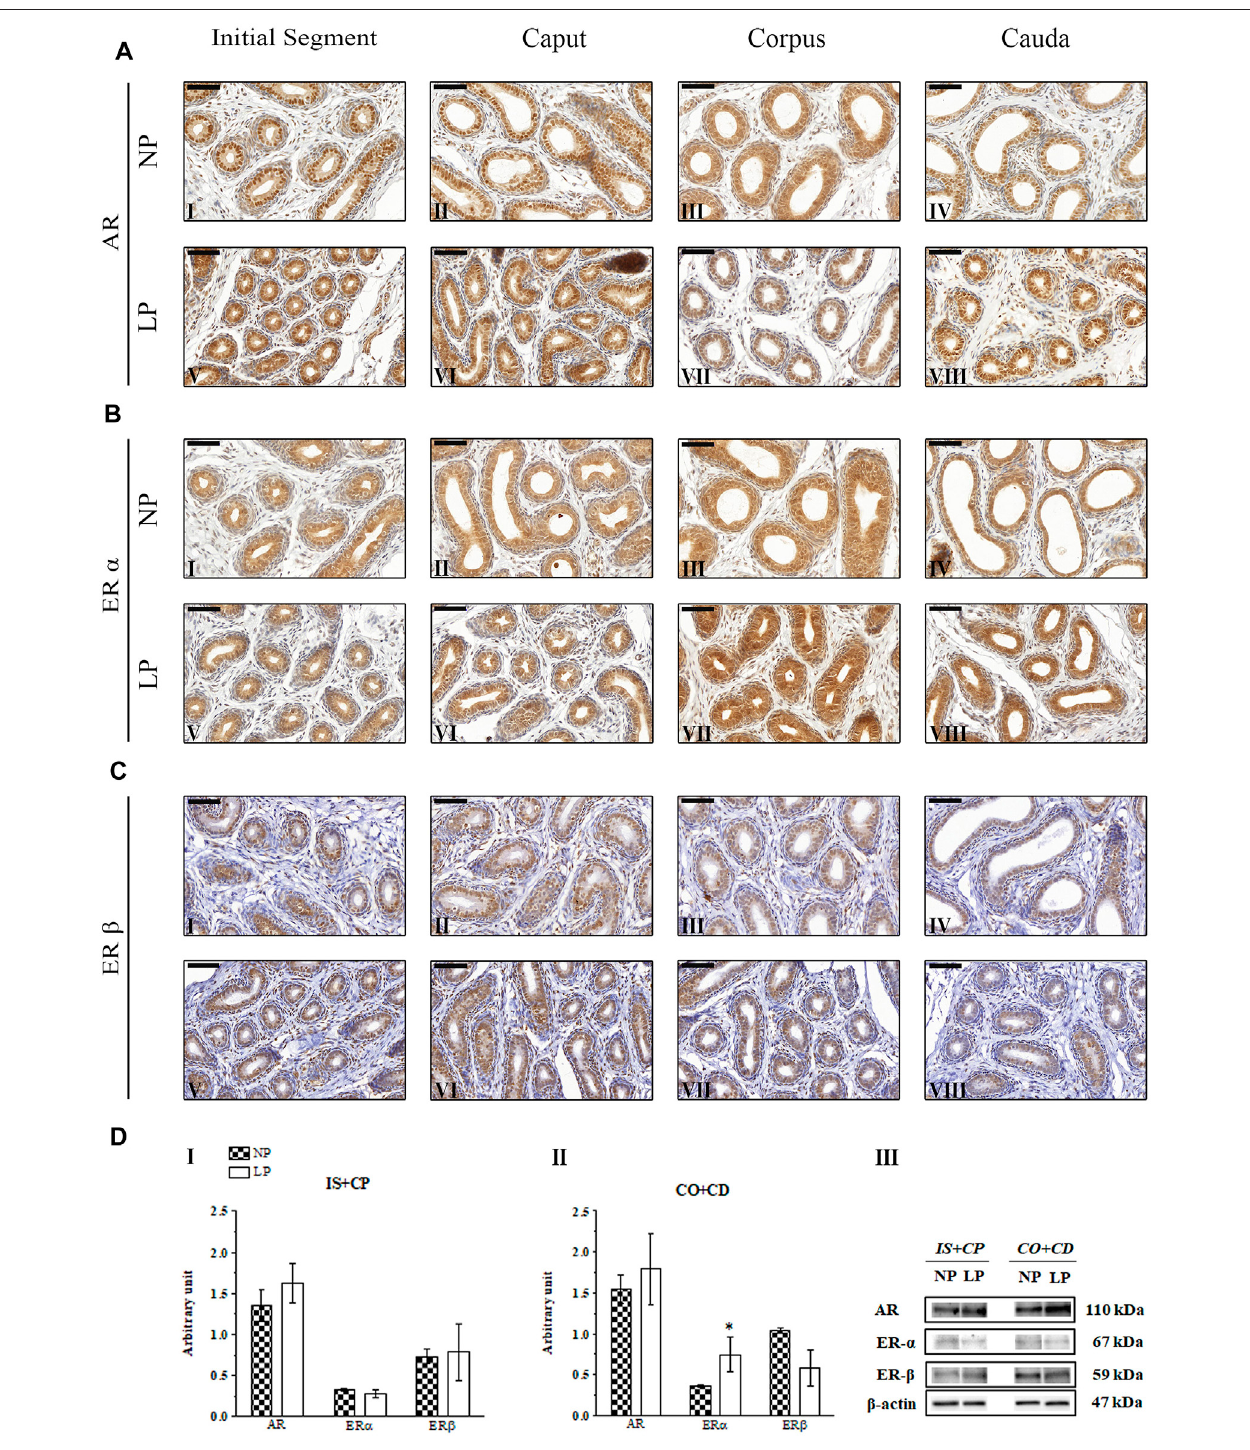
FIGURE4| ExpressionandimmunolocalizationofAR,ER α andER β intheepididymidesof21-day-oldanimals. (A) ImmunoreactivityforARinepithelialcellsandin mesenchymal cells in the initial segment ( I and V ), caput ( II and VI ), corpus ( III and VII ) and cauda ( IV and VIII ) regions of NP and LP animals. (B) Immunoreactivity for ER α inepithelialcellsandinmesenchymalcellsintheinitialsegment( IandV ),caput( IIandVI ),corpus( IIIandVII )andcauda( IVandVIII )regionsofNPandLPanimals. (C) ImmunoreactivityforER β inepithelialcellsandinmesenchymalcellsintheinitialsegment( IandV ),caput (IIandVI ),corpus( IIIandVII )andcauda( IVandVIII ) regions of NP and LP animals. Bar = 50 µm. (D) Extracts obtained from individual animals were used for densitometric analysis of the levels of the proteins in the initial segmentplus caput ( I )and the corpusplus cauda( II )regionsfollowing normalization tothelevels ofthehousekeepingprotein β -actin. Therepresentative blotsshow the protein levels of AR, ER α , ER β and β -actin ( III , right panel). The data are presented as the mean ± S.E.M. * p < 0.05, Mann-Whitney test.